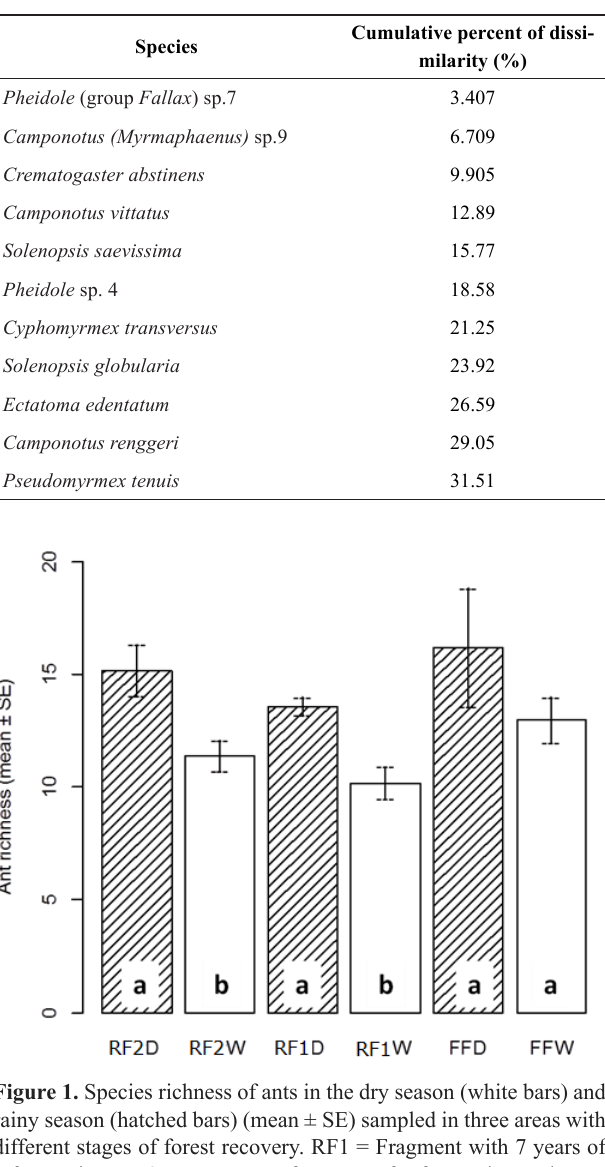
Table 3. SIMPER Analysis among three sites of different forest re- generation stages: a fragment of secondary forest (FF) one area of reforestation with five years (RF2) and other with seven years of reforestation (RF1).